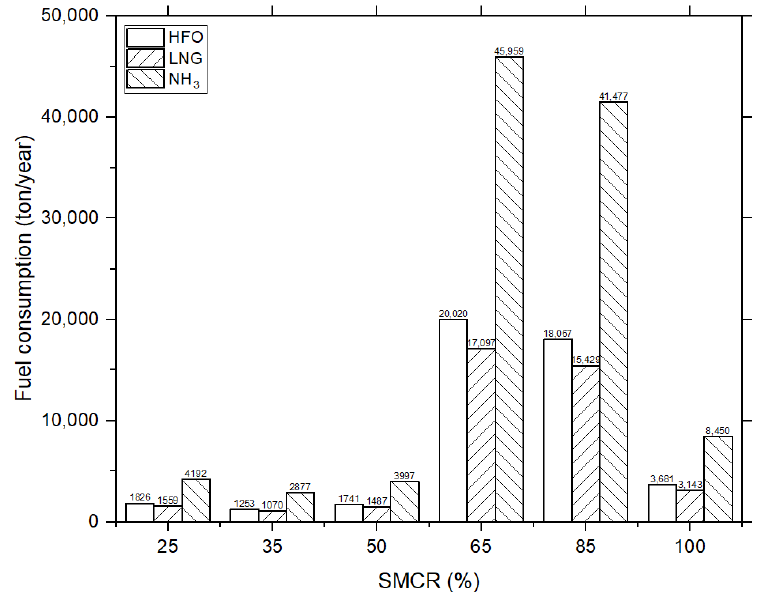
16 of 23 Figure 7. NPV for the NH 3 and re-liquefaction price. LCC for NH 3 and LNG